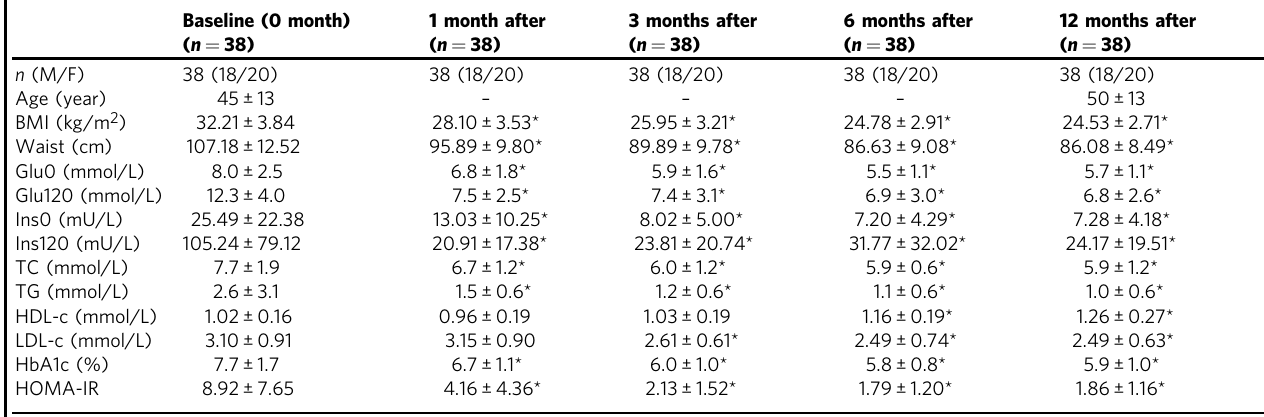
Table 2 Metabolic markers of patients with diabetes at baseline (0 m) and 1, 3, 6, and 12 months after surgery in the gastric bypass surgery intervention